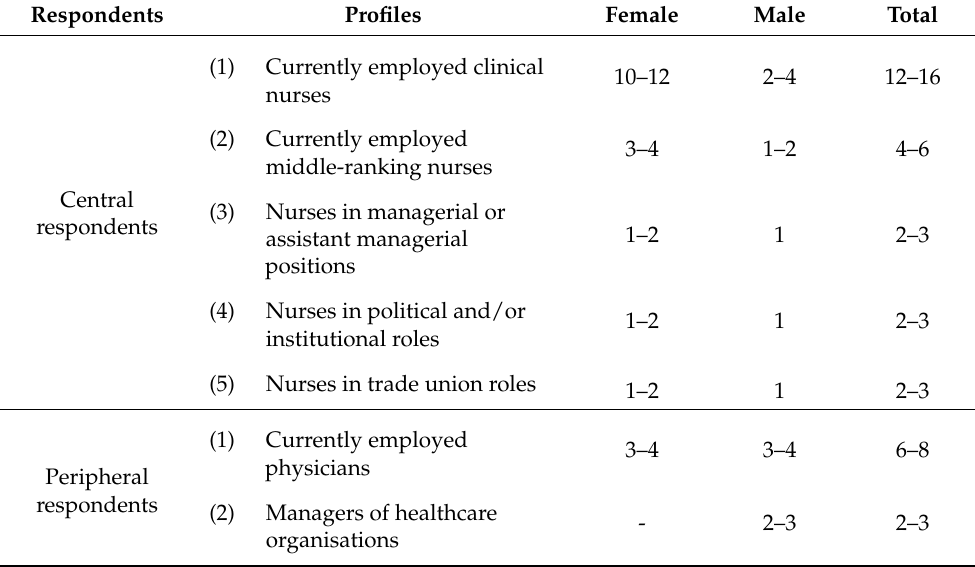
Table 1. The initial sample of participants for inclusion in the study by profile and